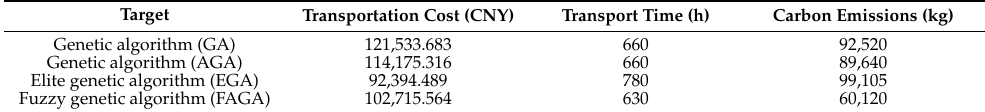
Table 11. Multi-objective optimization results of GA, AGA, EGA and FAGA algorithms.